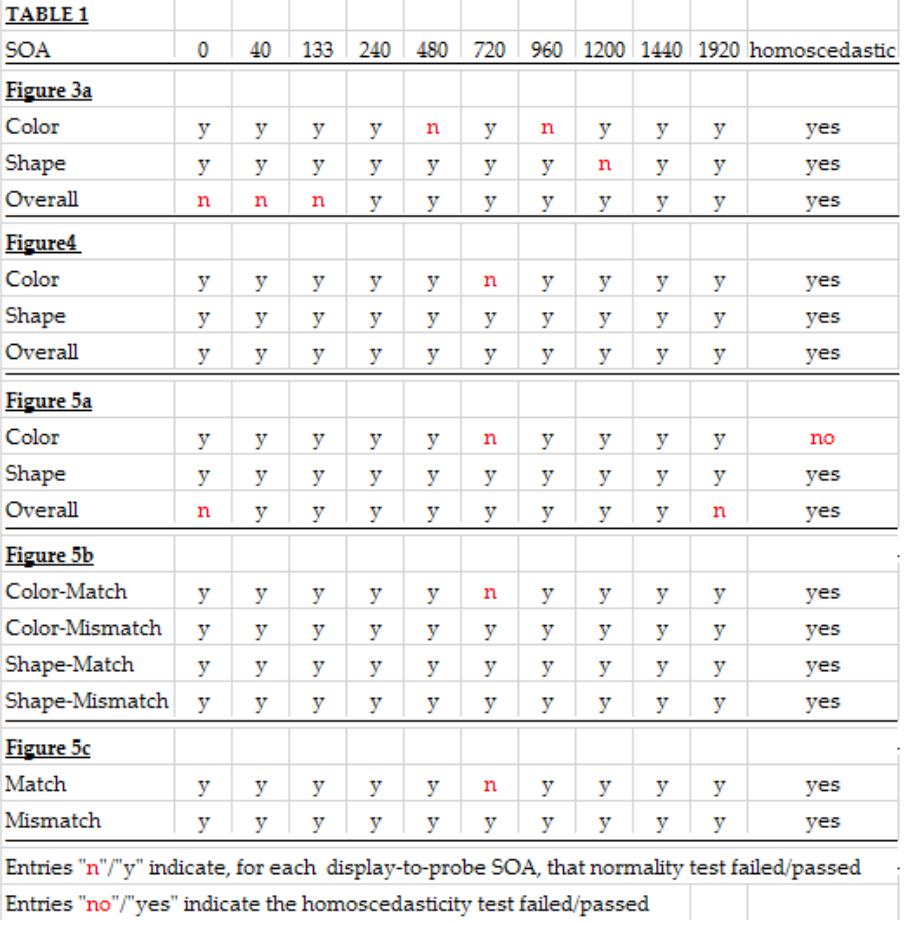
Figure A1. Figure A1. Results of normality and homoscedasticity tests for the data used in Figures 3A, 4 and